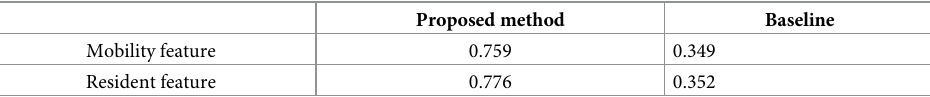
Table 7. MRR values for verifying the information in the mobility and resident embedding